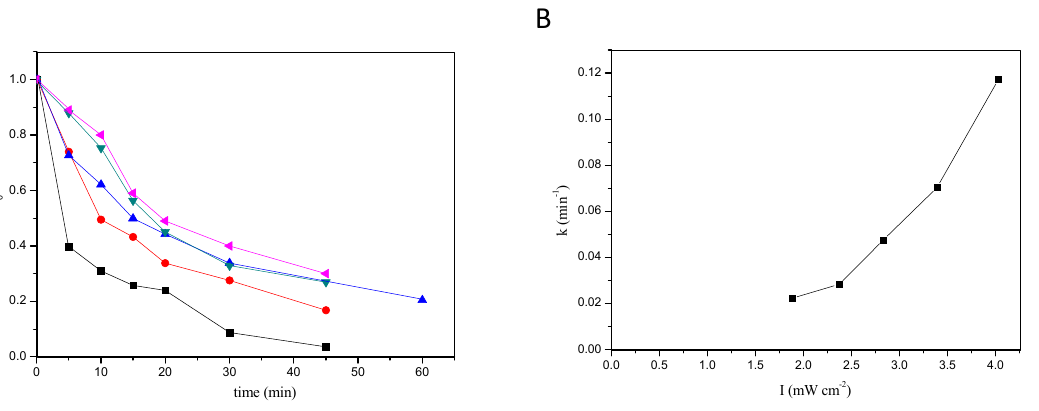
Figure 6. ( A ) Effect of incident UV ‐ A radiation intensity on the degradation of simulated wastewater containing 40 mg L − 1 CLPR in the presence of the photo ‐ Fenton reagent (7 mg L − 1 Fe 3+ , 100 mg L − 1 H 2 O 2 , pH: 3.0): [ ■ ] I = 4.03 mW cm − 2 , [ ● ] I = 3.39 mW cm − 2 , [ ▲ ] I = 2.83 mW cm − 2 , [ ▼ ] I = 2.37 mW cm − 2 , [ ◄ ] I = 1.88 mW cm − 2 . Total volume: 15 L, illuminated volume: 5 L.; ( B ) effect of the intensity of incident UV ‐ A radiation on the reaction rate constant, k.